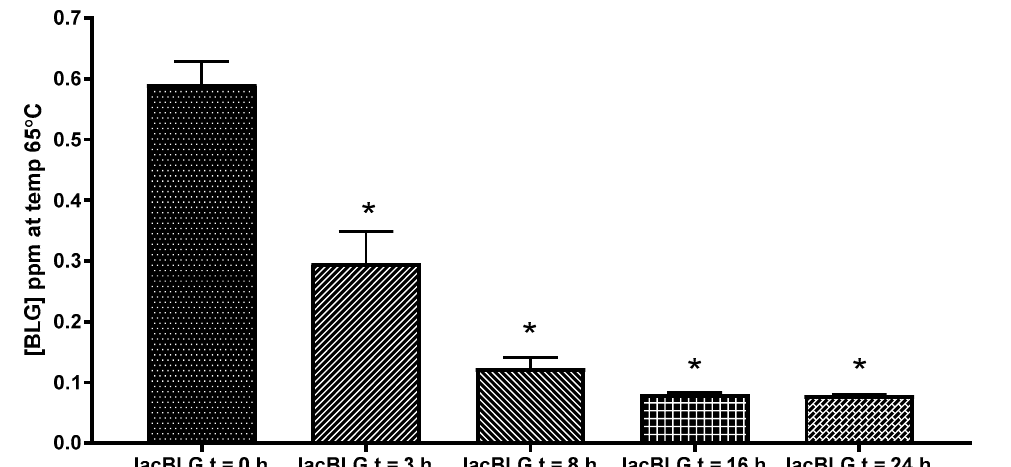
Figure 6. IgG binding (antigenicity) of lactosylated BLGWT (lacBLG) in duplicate using a BLG ELISA. Data are expressed as mean + SD.* One-way ANOVA p = <0.0001. 3.5. Degranulation Capacity of Lactosylated BLG using RBL-h ε Ia-2B12 cells